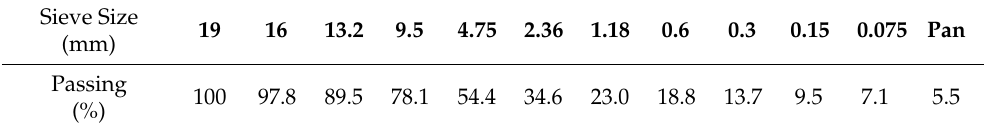
Table 1. Aggregate gradations of five asphalt